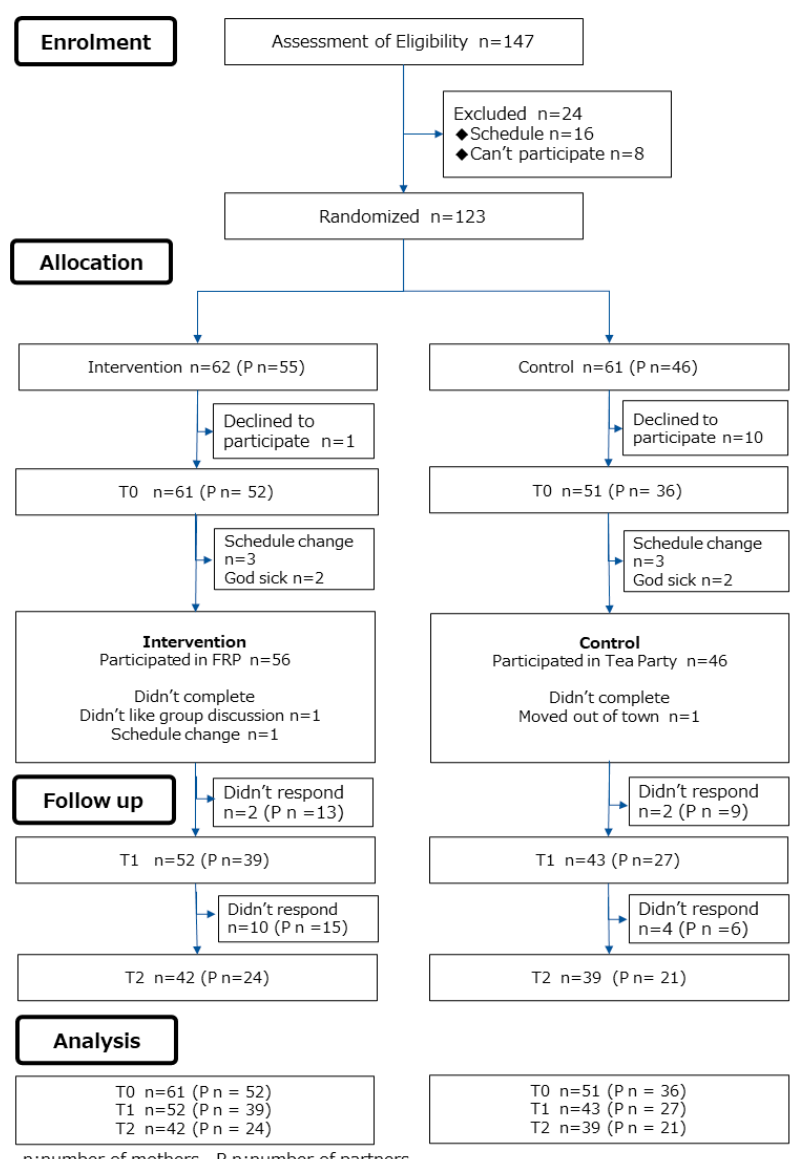
Figure 1. Flowchart. Figure 1.